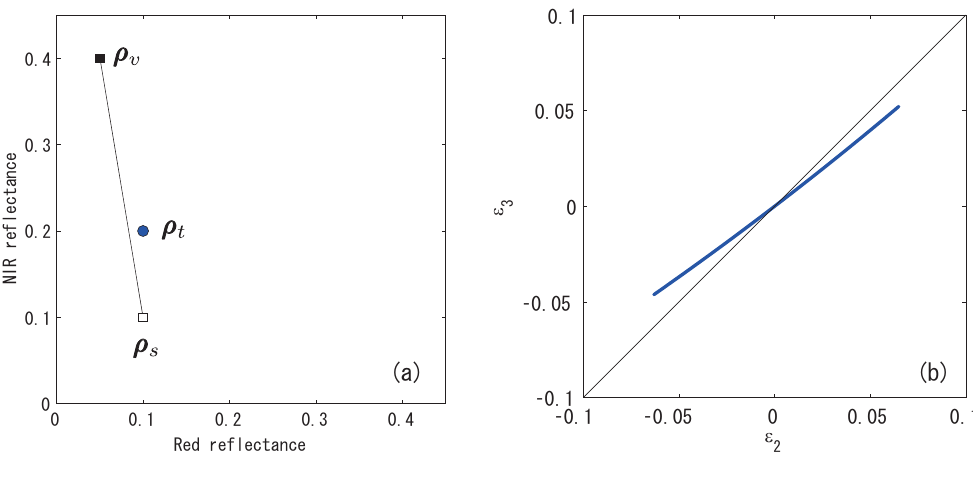
Figure 4. Example of the relationship between (cid:15) spectrum, and non-vegetation endmember spectrum denoted by the blue dot, filled squares and empty squares, respectively. The values are the same as those shown in Figure 2 except non-vegetation endmember spectrum; ( b ) The error relationship between algorithm-2 and